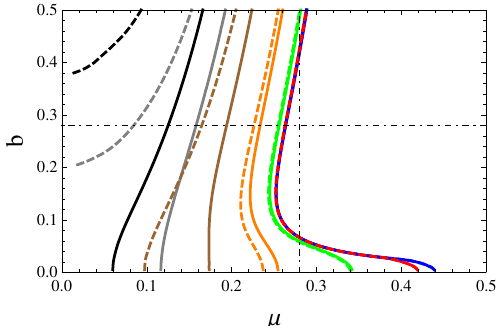
Figure 7 . Phase diagram for the chiral transition in the ( b; (cid:22) ) plane. Each critical line divides the plane in two sides corresponding to the chirally broken (left) and chirally symmetric (right) phases. Di(cid:11)erent colors correspond to di(cid:11)erent temperatures v T = 0 (blue), v T = 0 : 02 (red), v T = 0 : 1 (green), v T = 0 : 2 (orange), v T = 0 : 3 (brown), v T = 0 : 36 (gray) and v T = 0 : 4 (black). The solid lines are the results using the full numerical solutions for the chirally broken phase. The dashed lines are the results using the PRS approximation. The dot-dashed horizontal and vertical lines correspond to the cases b = const and (cid:22) = const respectively. The intersection between those lines and the solid lines allows us to extract the critical values (cid:22) c ( b ) and b c ( (cid:22) ) respectively.